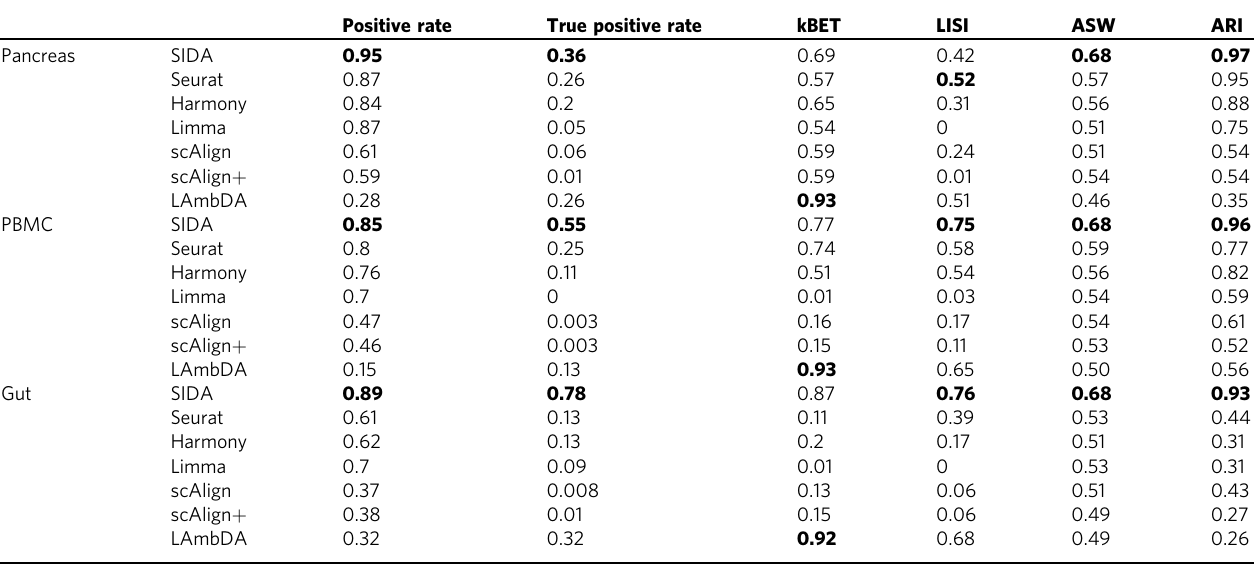
Bold indicates the best performance for each metric in each data